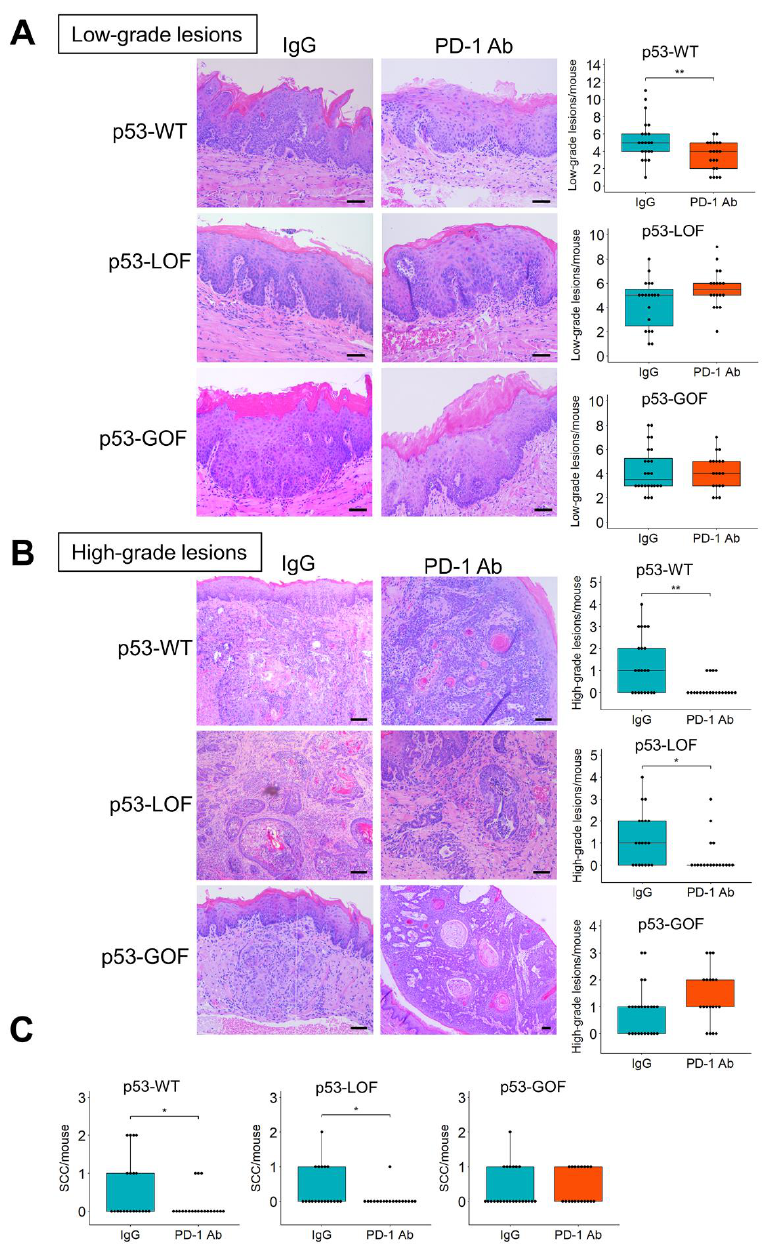
Figure 5. Epithelial mutant p53 R172H blocks the potential of anti-PD-1 to prevent the progression of OPLs. ( A , B ) H&E staining of 4NQO-induced ( A ) low-grade lesions or ( B ) high-grade lesions that developed in the tongues of mice treated with control IgG or anti-PD-1. Quantification of the lesions is shown on the right panels. Bar = 100 μm ( C ) Quantification of SCCs in mice treated with anti-PD1 or control IgG. The p53 status of the mice is indicated at the top of each graph. * p < 0.05, ** p < 0.01.